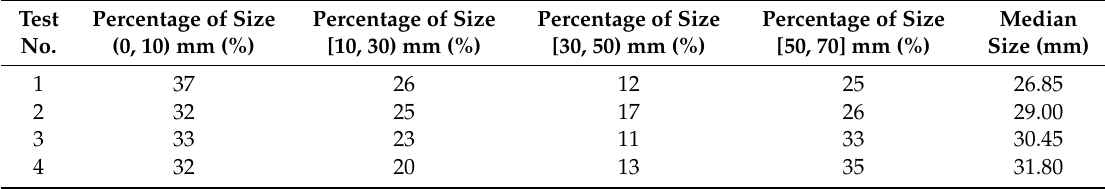
Table 2. Particle size distribution of green cokes.